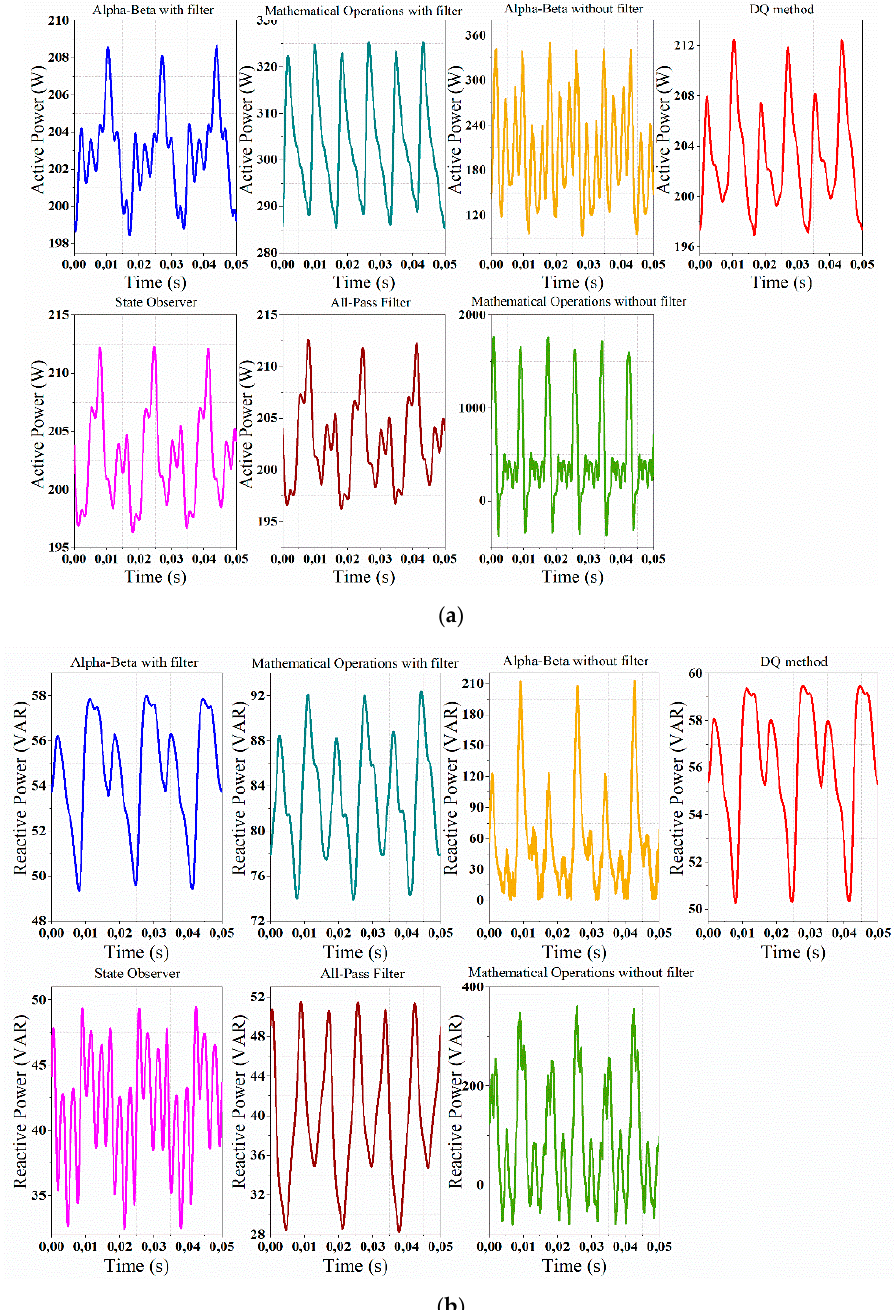
Figure 13. Power calculation at fundamental frequency + 3rd harmonic + 5th harmonic: ( a ) active power; ( b ) reactive power.